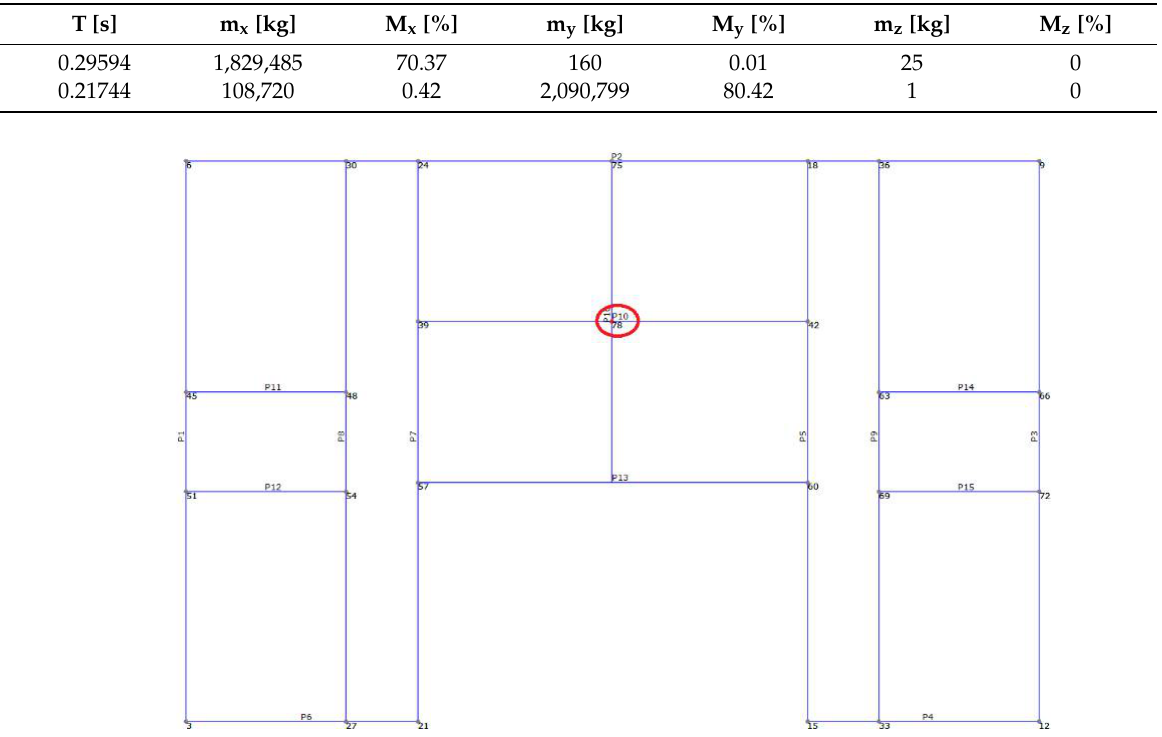
Table 3. Modal analysis results.